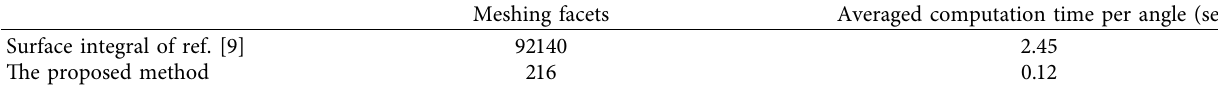
Table 1: Comparison of computation complexity between contour and surface integrals.